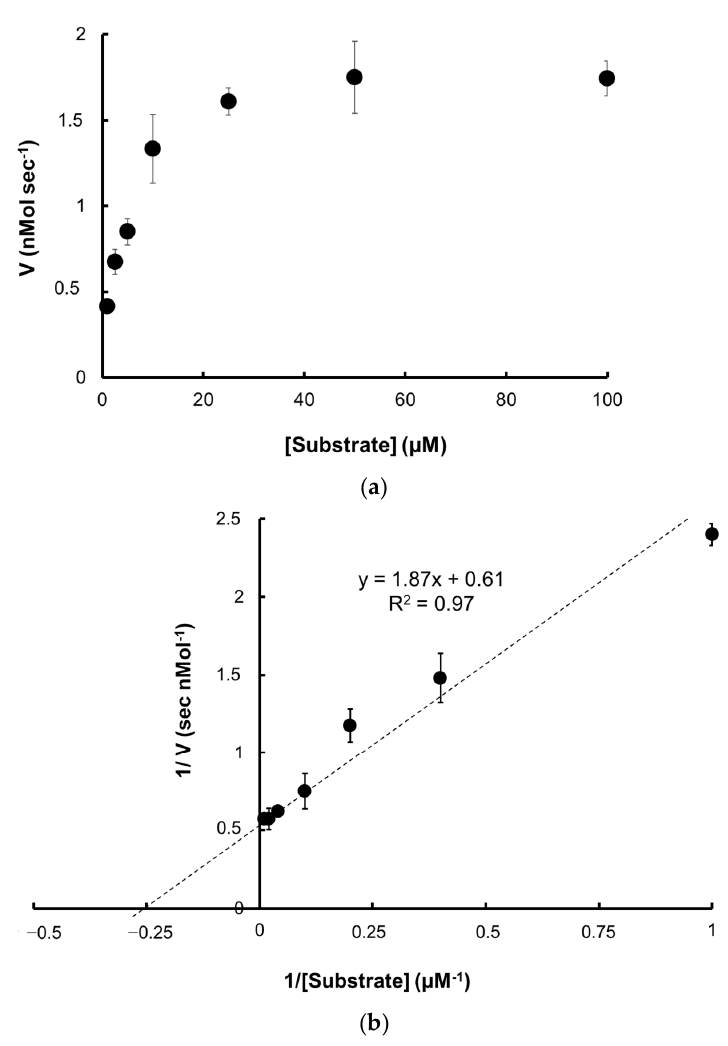
Figure 6. ( a ) Michaelis–Menten curve; ( b ) Lineweaver–Burk plot of the Pk-ClpP.